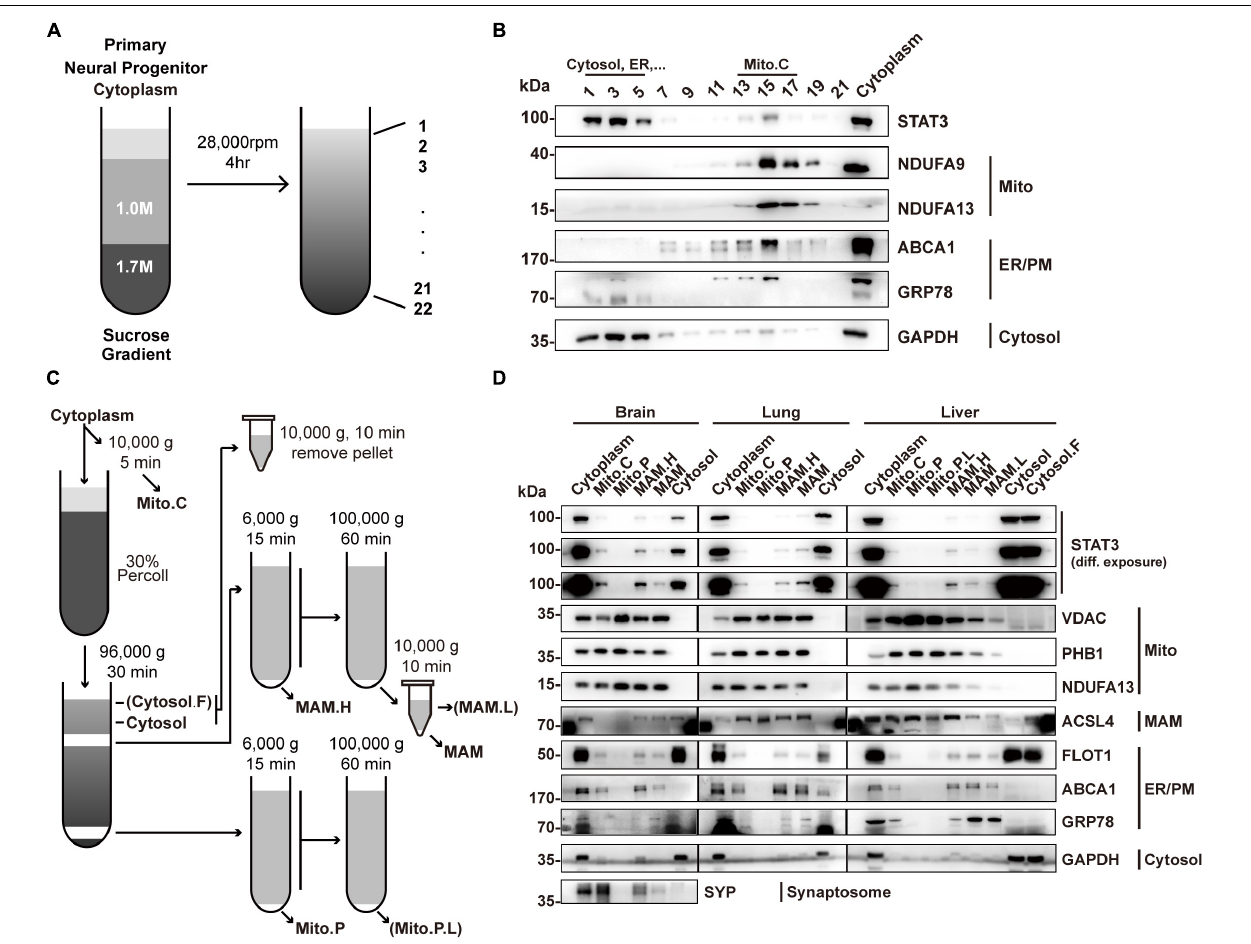
FIGURE 1 | Percoll cell fractionation demonstrates that STAT3 does not exist in the mitochondria. (A) Experimental flow-chat for cell fractionation. (B) Western blots of cell fractionation. STAT3 was mainly found in Cytosol (fraction 1–5) and in crude mitochondria (fraction 13–17). (C) Experimental flow-chart of Percoll density centrifugation for MAM and pure mitochondria separation. Parentheses highlight fractions only obtained from liver. (D) Western blot of Percoll density centrifugation fractionation of brain, lung and liver. Pure mitochondria do not contain STAT3. The purity of mitochondria was confirmed by the absence of ER/PM marker. PM, plasma membrane; Mito.C, crude mitochondrial fraction; Mito.P, pure mitochondrial fraction; Mito.P.L., light pure mitochondria; MAM.H, heavy MAM; MAM.L, light MAM; Cytosol.F, cytosol fraction that contains fat; NDUFA9/13, NADH:ubiquinone oxidoreductase subunit A9/13; FLOT1, Flotillin-1; PHB1, Prohibitin